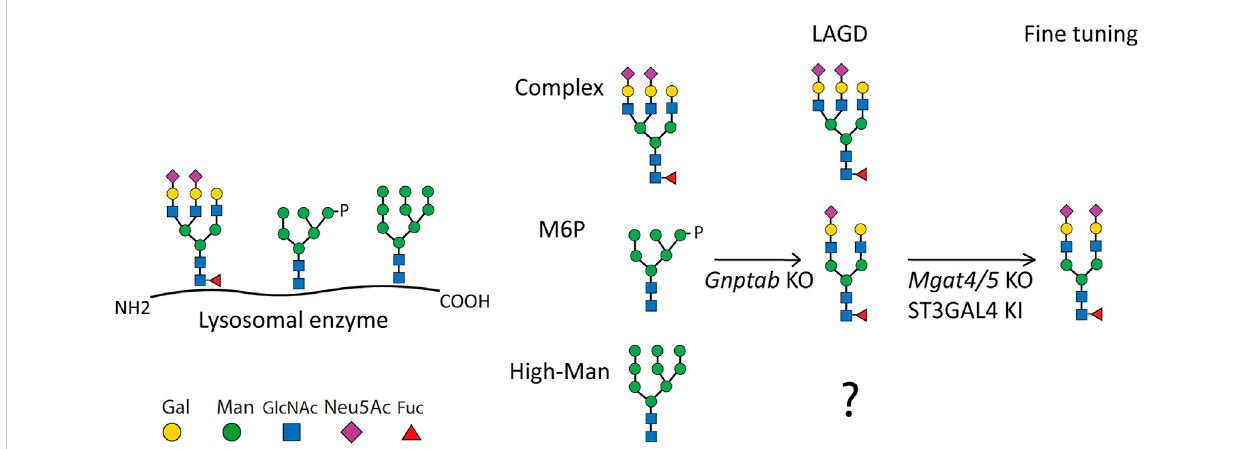
FIGURE 1 Depiction of the LAGD glycoengineering strategy for lysosomal enzymes. The three principle types of N-glycan structures are illustrated with the predicted outcomes indicated after KO of Gnptab in CHO cells. Further fi ne-tuning steps to obtain homogeneous complex biantennary N-glycans with α 2-3sialicacidcappingareshown(Tianetal.,2019).GlycansymbolsaccordingtoSymbolNomenclatureforGlycansformat.Galdenotesgalactose,Man denotes mannose, GlcNAc denotes N-Acetylglucosamine, Neu5Ac denotes N-Acetylneuraminic acid, Fuc denotes fucose, and P denotes